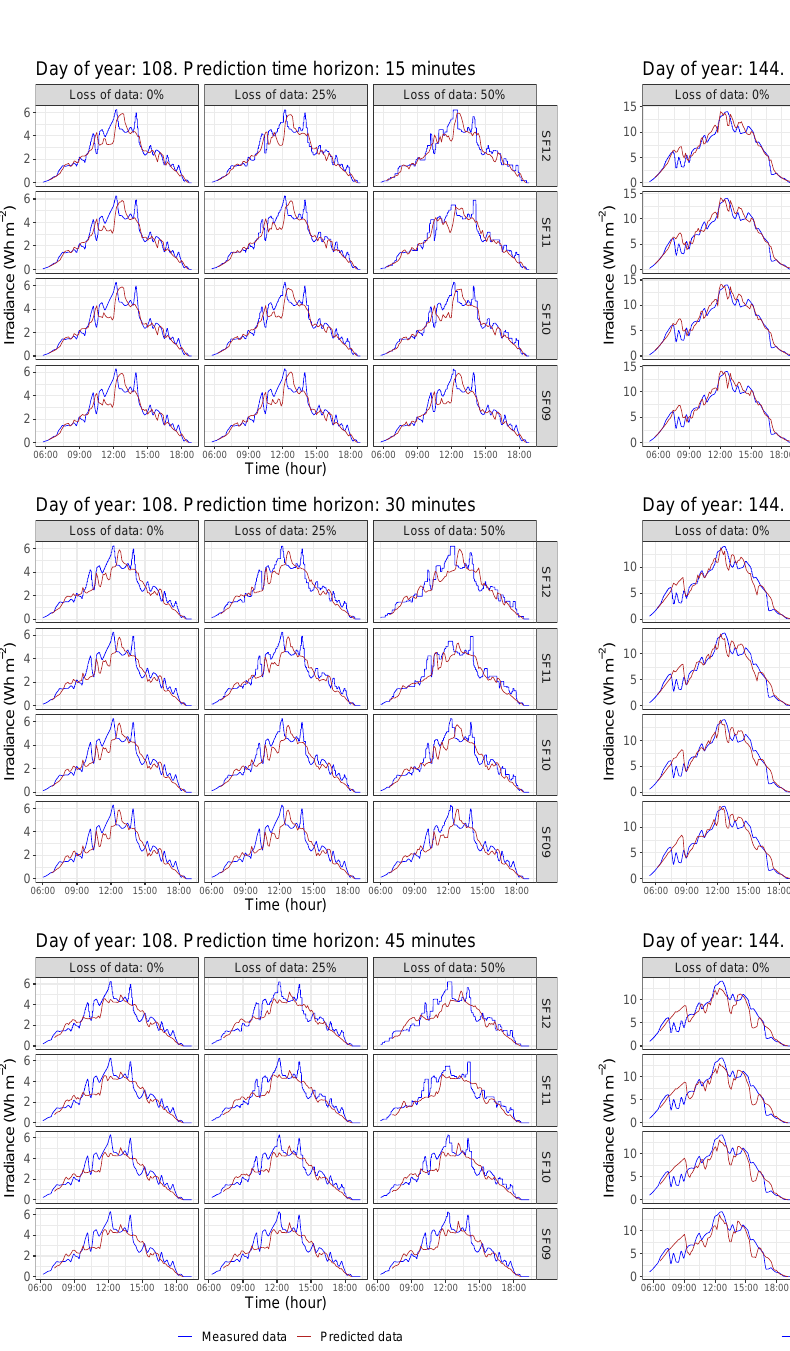
Figure 11. Comparison of estimated and monitored GHI data for different time horizon, SF, and loss of data